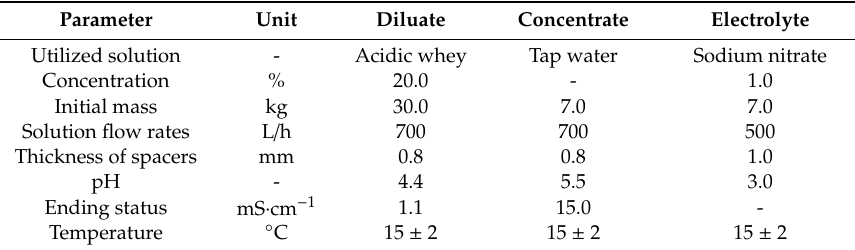
Table 4. Process conditions.